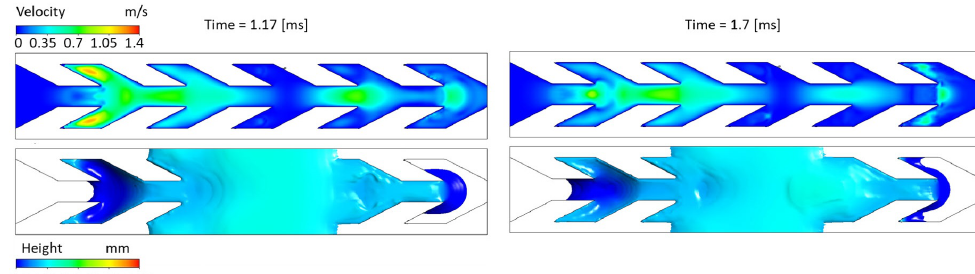
Figure 15. Spreading of water beyond the pinning point ( t = 1.17 ms) and backflow ( t = 1.70 ms) for a static contact angle θ = 30°. Velocities and liquid height are documented at the top and bottom of each figure, respectively. The initial condition is a two elementary cells long liquid parallelepiped. The channel geometry corresponds to the pattern A.